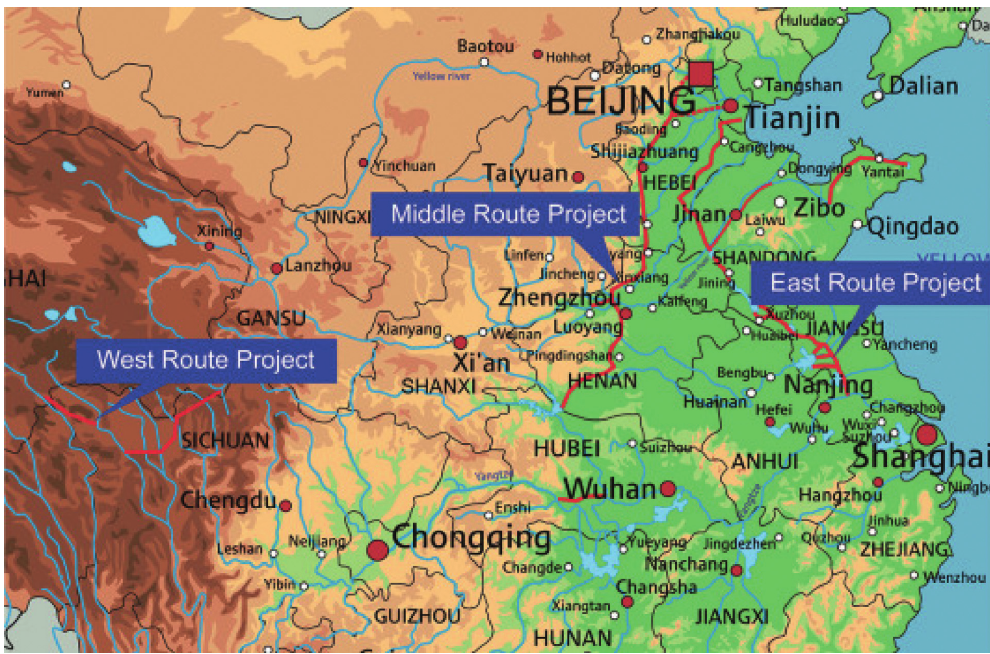
Figure 1: The three routes of the South-to-North Water Diversion